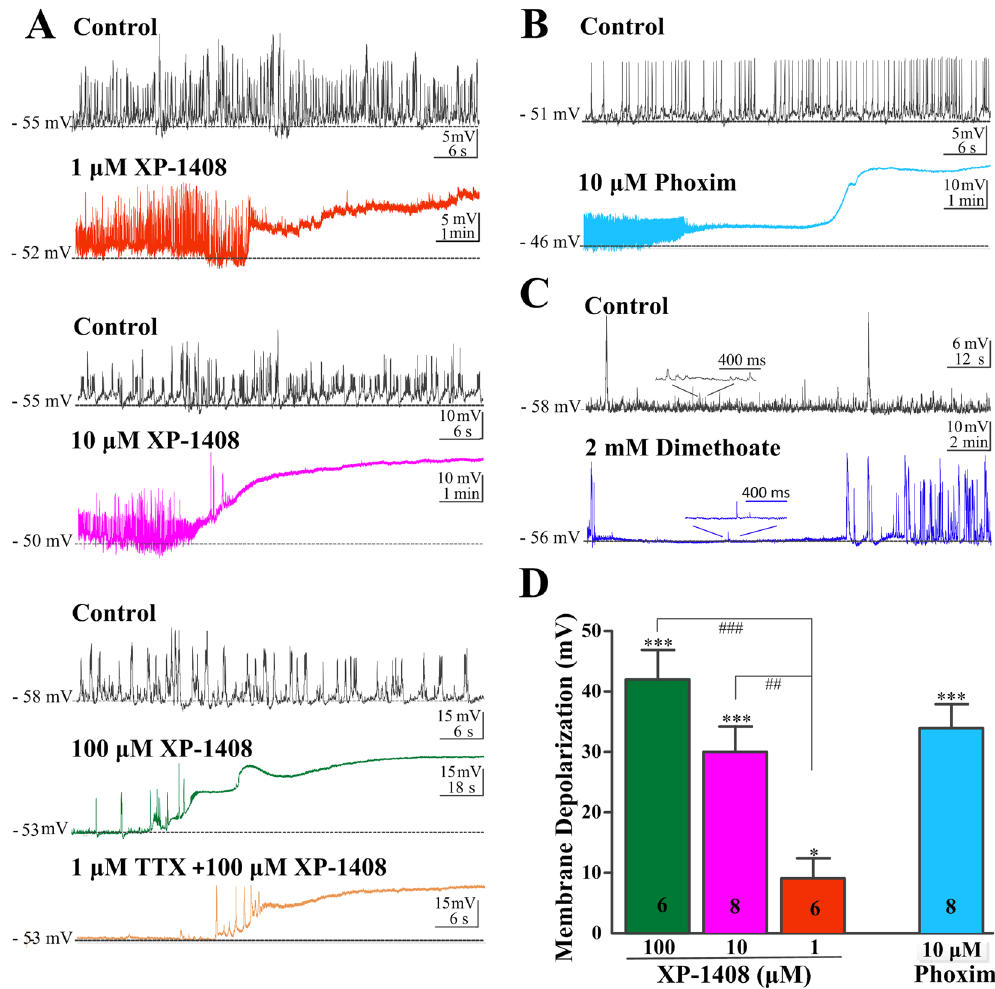
Figure 4. Effects of XP-1408 on spontaneous activities and resting membrane potentials in Drosophila PNs. ( A ) Representative voltage traces of individual PNs exposed to different XP-1408 concentrations (bath application). In the presence of XP-1408, a rapid depolarization was seen accompanied with activation of a high frequency burst of spontaneous activities, followed by inhibition of all activities. Preincubation of 1 μ M TTX only partially suppressed the depolarization induced by XP-1408. ( B ) Current clamp recordings before (upper trace) and 10 min after application of phoxim (10 μ M) (bottom trace) from PNs. ( C ) Current clamp recordings before and 10 min after application of dimethoate (2 mM) from PNs. Inset, the high time resolution of the indicated region. ( D ) Population data summarizing the peak amplitude of the depolarization induced by XP-1408 and phoxim. XP-1408 mediated depolarization was obvious in the range of 1–100 μ M concentration, and significantly differed between low concentration (1 μ M) and high concentration (10 μ M and 100 μ M). There was no significant difference in depolarization amplitude between XP-1408 and phoxim at 10 μ M concentration. Each bar indicates the means ± SEM from indicated neurons